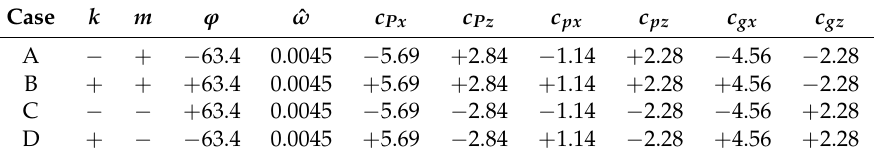
Table 1. The characteristics of plane Boussinesq gravity waves for the four wavenumber vectors (cid:126) k A (A), (cid:126) k (cid:126) k (cid:126) k B (B), D (D) with horizontal and vertical wavenumber components are k C (C) and λ x = 8km and m = ± 2 π / λ z with λ z = 4km, respectively. The background stratification is N = 0.01s − 1